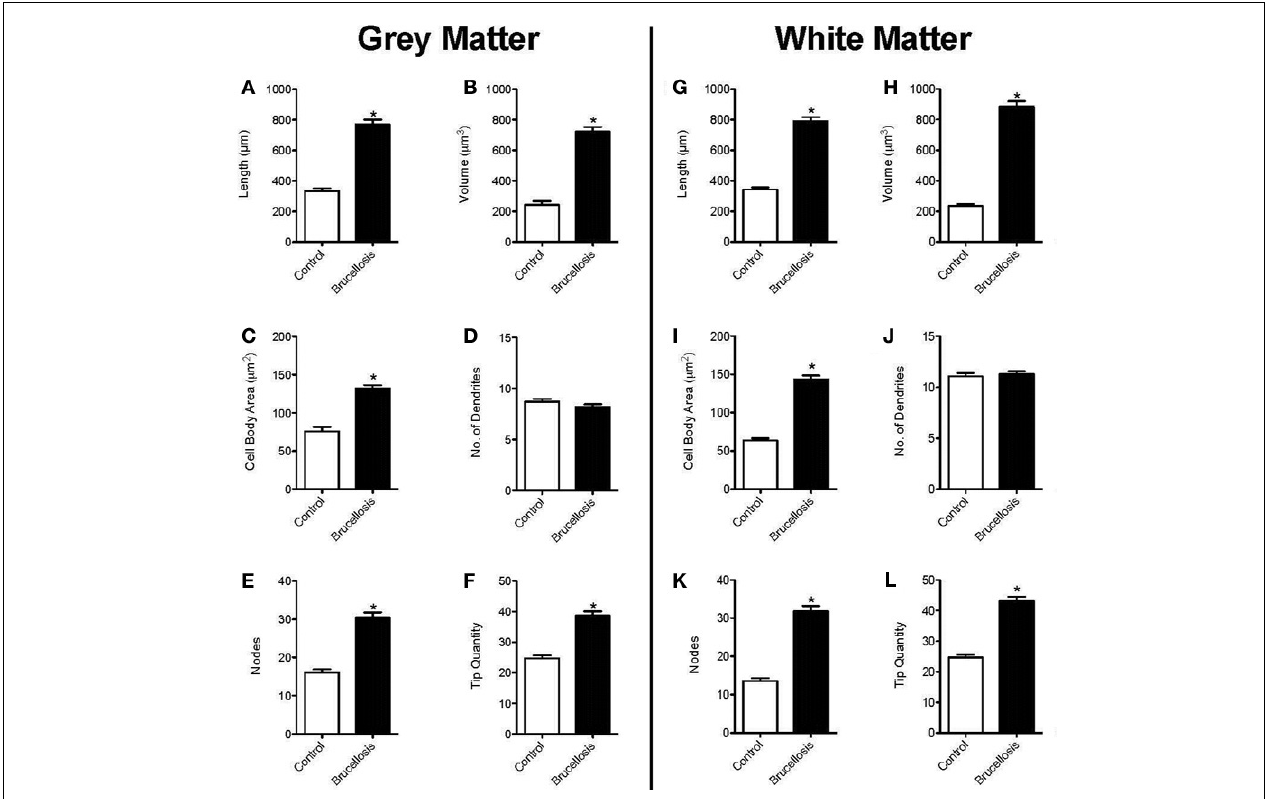
FIGURE 4 | B. melitensis infection induces astrocyte hypertrophy. The total length of processes of astrocytes from infected macaques were increased in both gray and white matter (A, G) . Similarly, the volume of the processes was increased (B, H) . This was coincident with a hypertrophied